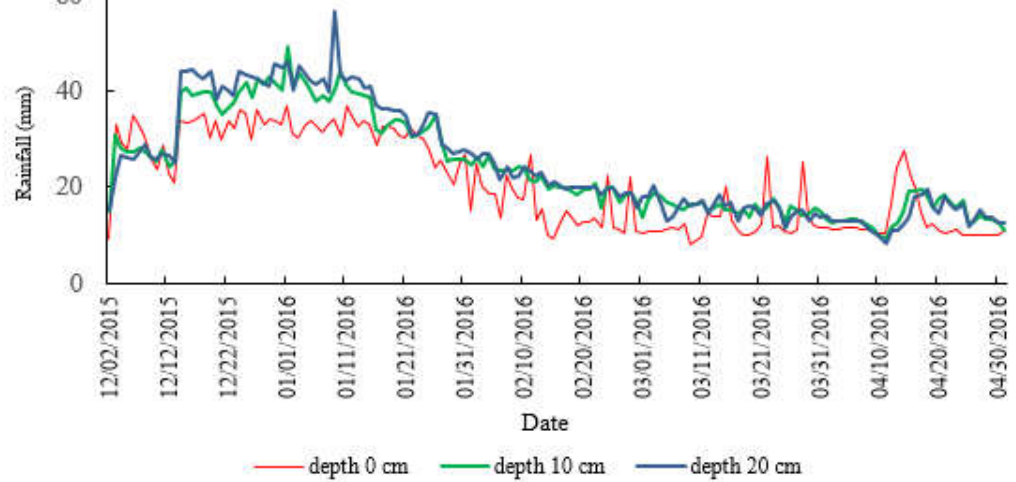
Fig. 4: A comparison of the amount of moisture in different soil depths of Green Roof